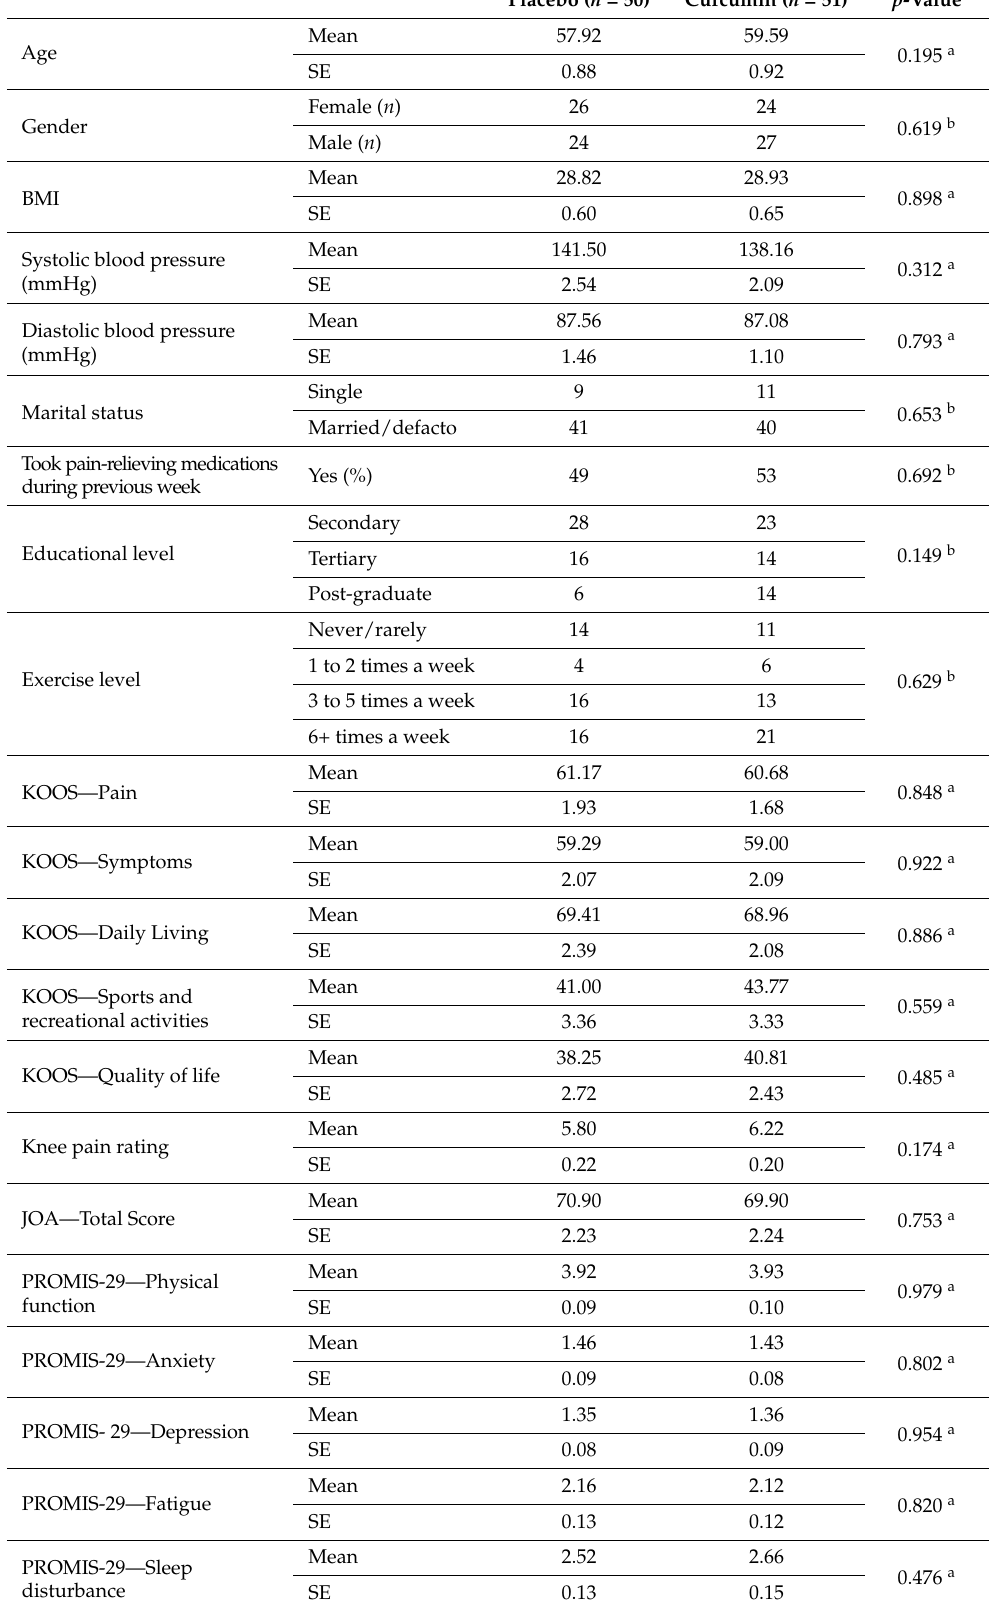
Table 1. Baseline Demographics Details and Questionnaire